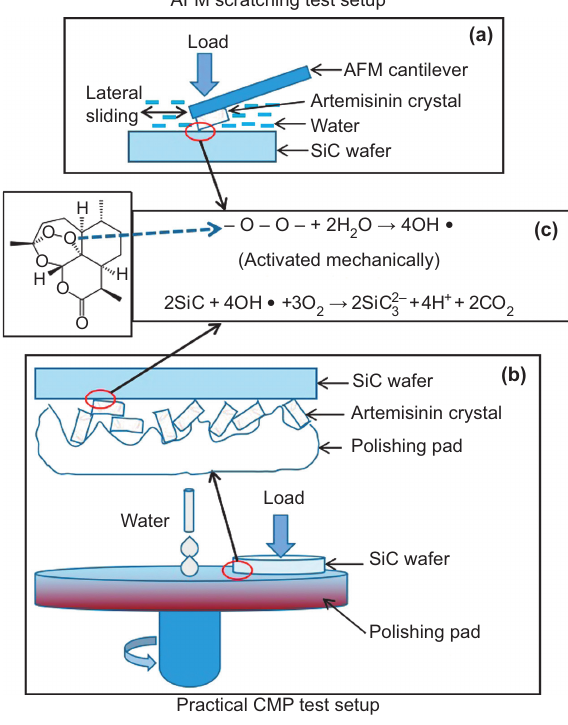
Figure 3. Proposed mechanism for